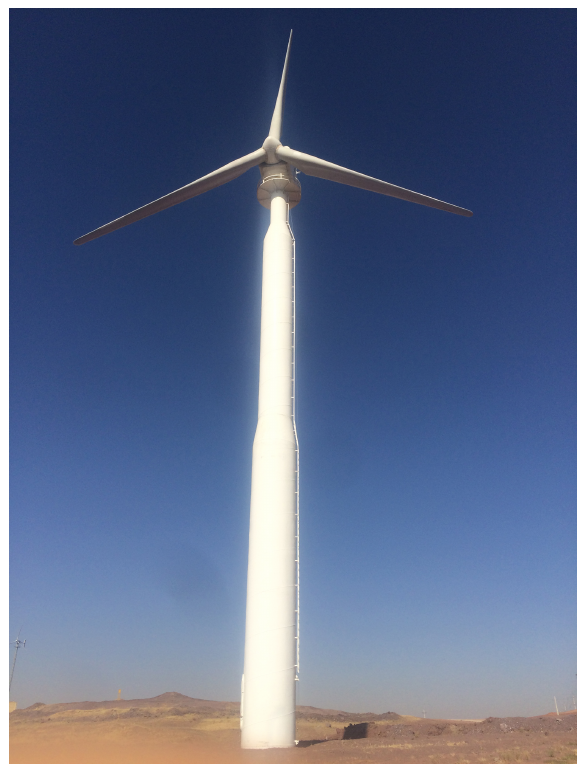
Figure 1. The studied wind turbine installed at a research wind